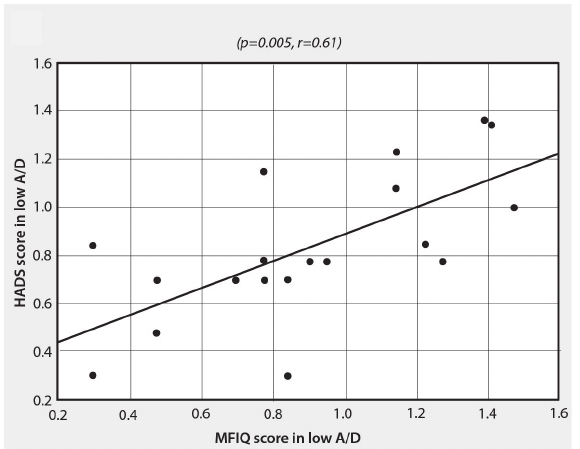
Figure 3- Correlation analysis of HADS score and MMO without pain in low A/D HADS=Hospital Anxiety and Depression Scale, MMO=maximum mouth opening, A/D=Anxiety/ High A/D